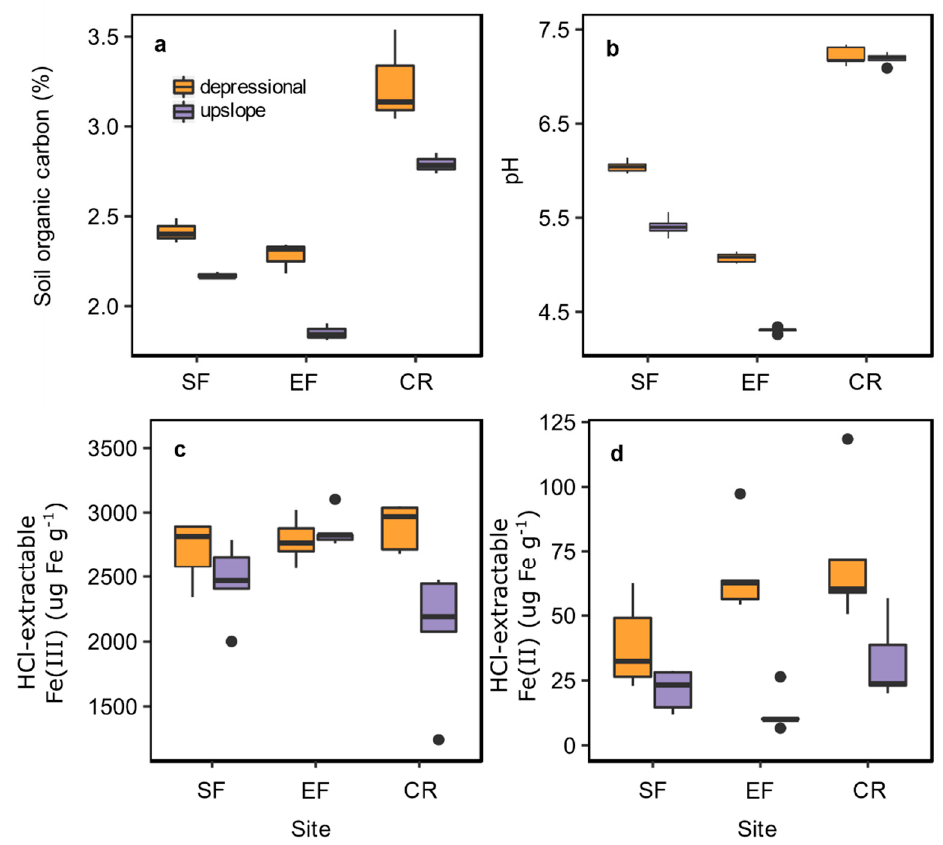
Figure 2. Soil organic carbon concentration ( a ), soil pH ( b ), 0.5N HCl-extractable Fe(III) concentration ( c ), and 0.5N HCl-extractable Fe(II) concentration ( d ) from upslope and depressional soils from the South Farms (SF), the Energy Farm (EF), and Cardinal Road (CR) ( n = 3 for C, n = 5 for pH, Fe(II), and Fe(III)). Colors represent the topographic position where soils were collected from within each site. The line in each box represents the mean, the upper and lower portions of each box correspond to the 25th and 75th percentiles, the whiskers extend to the upper and lower inter-quartile range, and dots represent outliers.